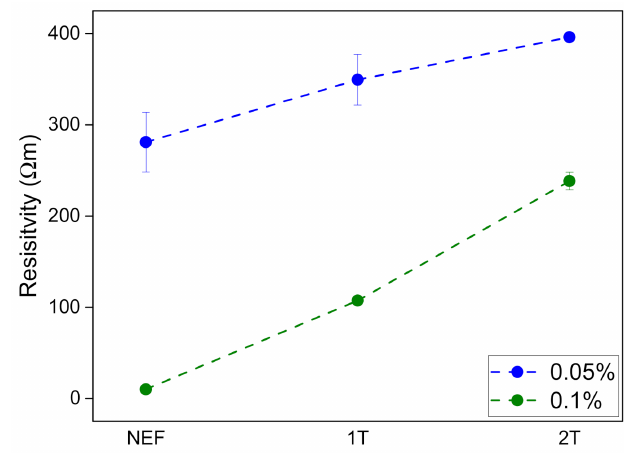
Figure 10. Electrical resistivity values of rGO coated